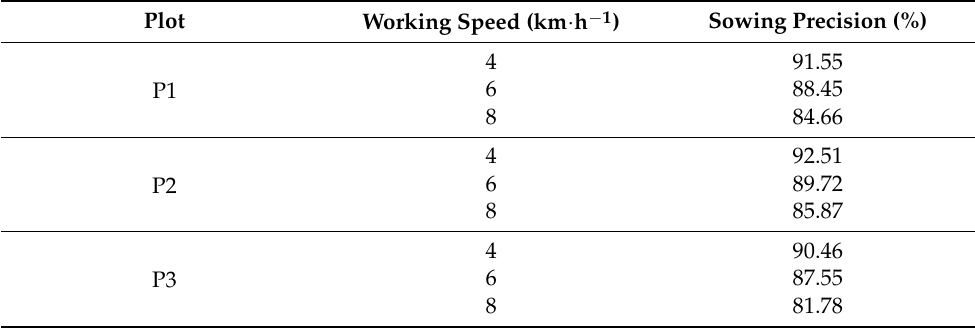
Table 7. Sowing precision determined by simulating the operating conditions on the